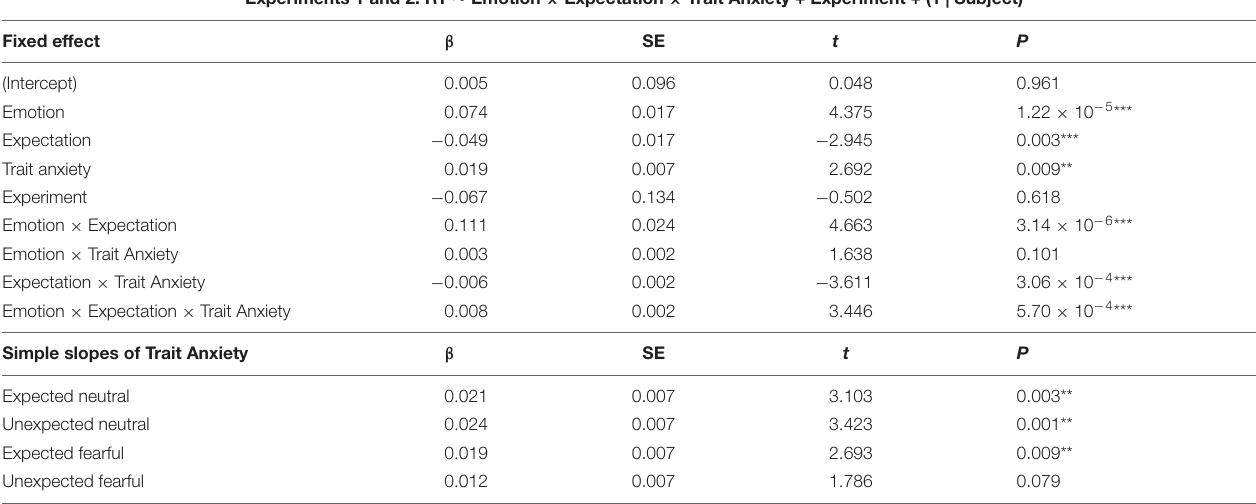
TABLE 2 | Response time models including anxiety for data pooled across Experiments 1 and